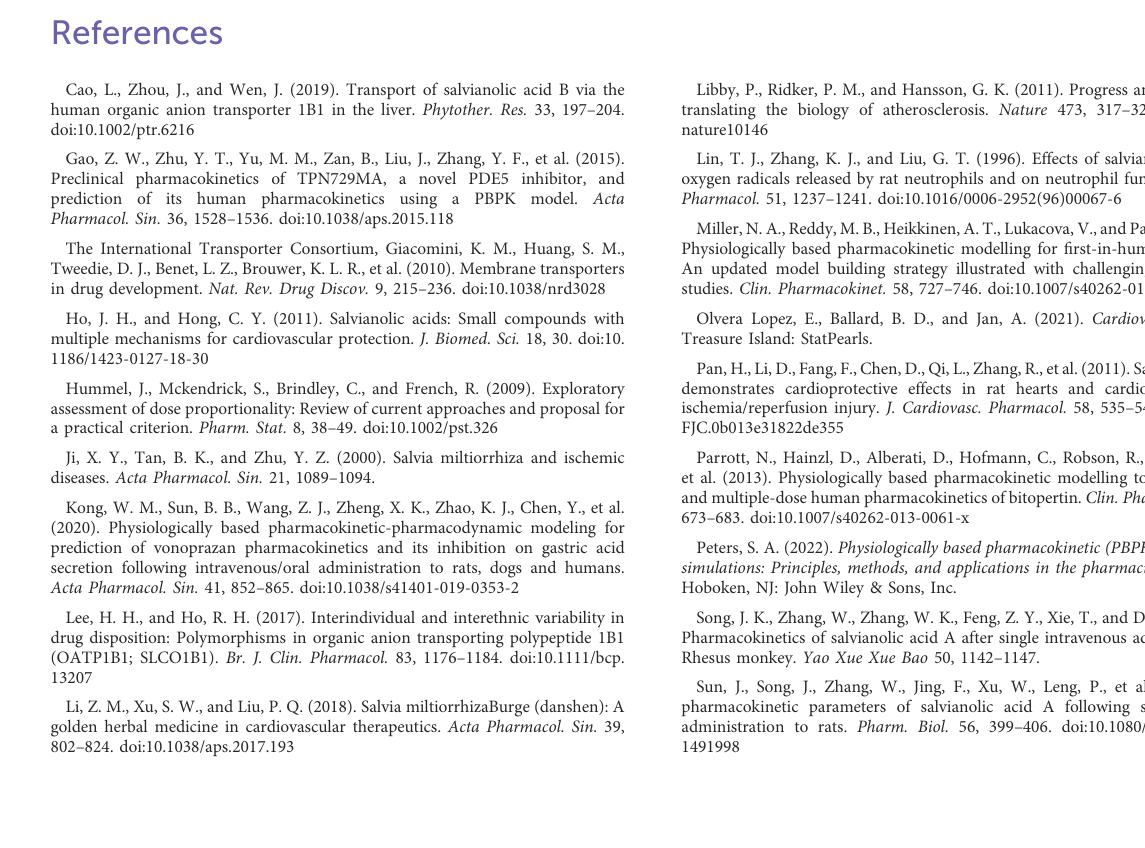
SUPPLEMENTARY FIGURE S1 Schematic illustration of the blood sampling process. (A) Single ascending dose, Part A; (B) multiple ascending doses, Part B. “ ↓ ” , pre- infusion blood sampling point; “ ↓ ” , infusion period blood sampling point; “ ↓ ” , post-infusion blood sampling point. SUPPLEMENTARY FIGURE S2 Mean (± SD) plasma concentration – time pro fi les, following the single ascending dose of SAA in male (closed circles) and female (open squares) subjects. SAA, salvianolic acid A. SUPPLEMENTARY FIGURE S3 Mean (± SD) plasma concentration – time pro fi les, following multiple ascending doses of SAA in healthy Chinese subjects. Each subject received twice-daily doses of SAA for 5 days and once on day 6. SAA, salvianolic acid